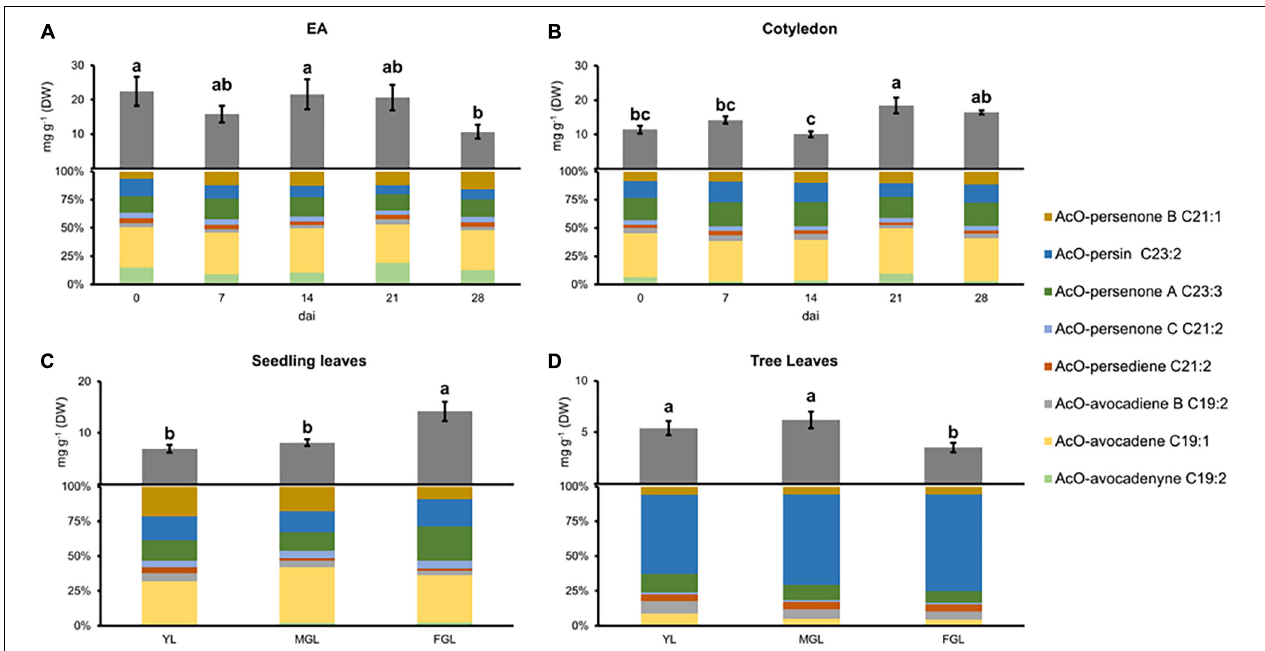
FIGURE 1 | Acetogenin content and composition in different avocado tissues. (A) EA, Embryonic axis. (B) COT, Cotyledon. (C) SDL, Seedling leaves. (D) TRL, Tree leaves. Error bars represent standard error (SE), different letters indicate statistical differences between treatments (ANOVA, Fisher LSD, P < 0.05). n = 4 for EA and Cotyledon; n = 3 for leaves. EA embryonic